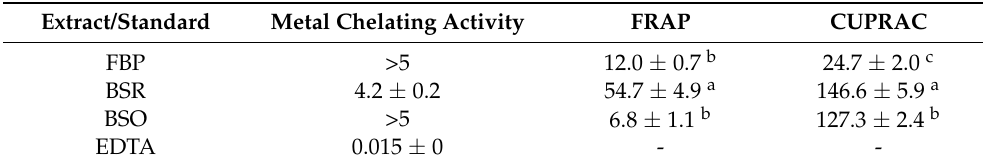
Table 3. Metal chelating activity (EC 50 , mg/mL) and ferric (FRAP) and cupric (CUPRAC) reducing powers (mg TE/g extract) of pulp and seed extracts of C. album berries. Extract/Standard